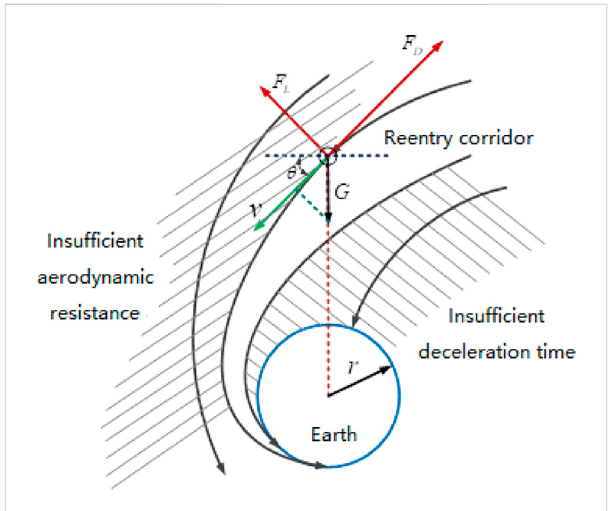
FIGURE 1 Schematic diagram of loading body entering deceleration and landing